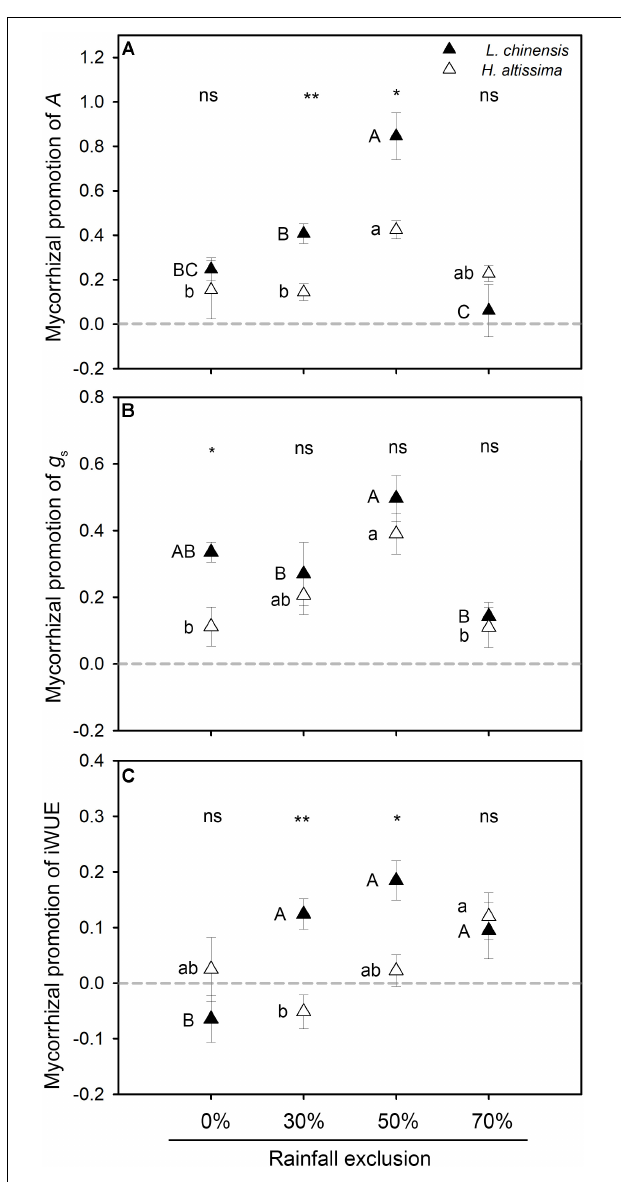
FIGURE 5 | Mycorrhizal response of photosynthesis characteristic, including (A) net assimilation rate ( A ), (B) stomatal conductance ( g s ), and (C) intrinsic water use efficiency (iWUE) in L. chinensis and H. altissima . Mycorrhizal benefit existed when values of mycorrhizal response were greater than zero. Different lowercase and capital letters indicate significant differences ( P < 0.05) among the rainfall exclusion treatments in L. chinensis and H. altissima , respectively. ∗ P < 0.05 and ∗∗ P < 0.01 indicates significant differences and ns ( P > 0.05) indicates no differences between L. chinensis and H. altissima . Data are reported as mean ± 1 SE ( n =